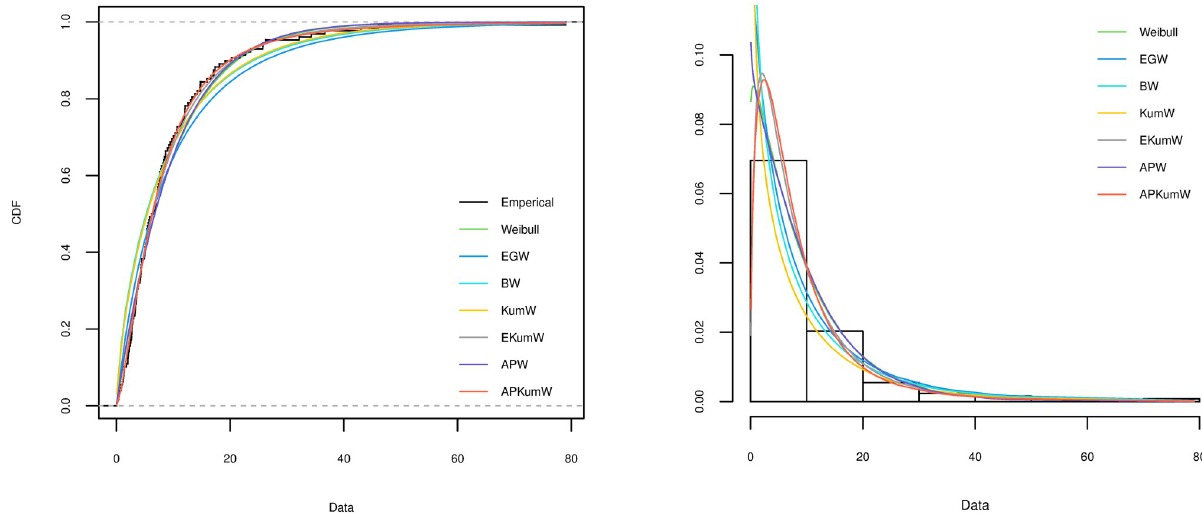
Fig 6. Theoretical and empirical cdf and pdf comparison of the bladder cancer II data.